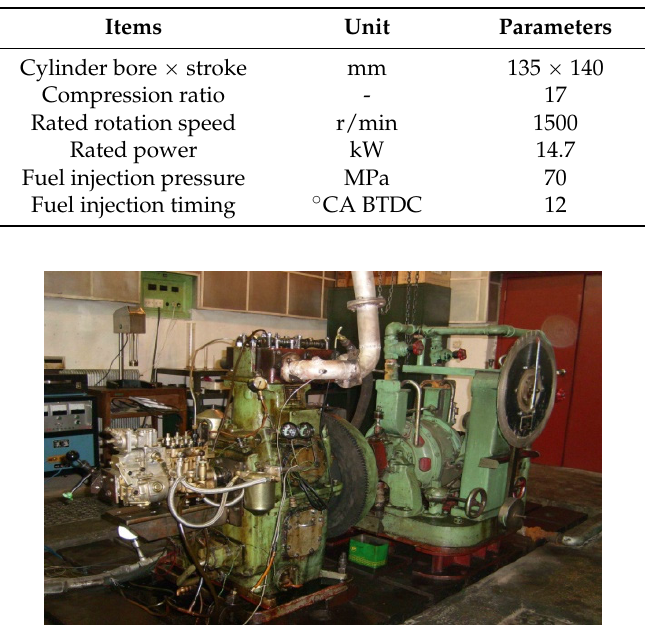
Figure 1. The research engine and test bench.